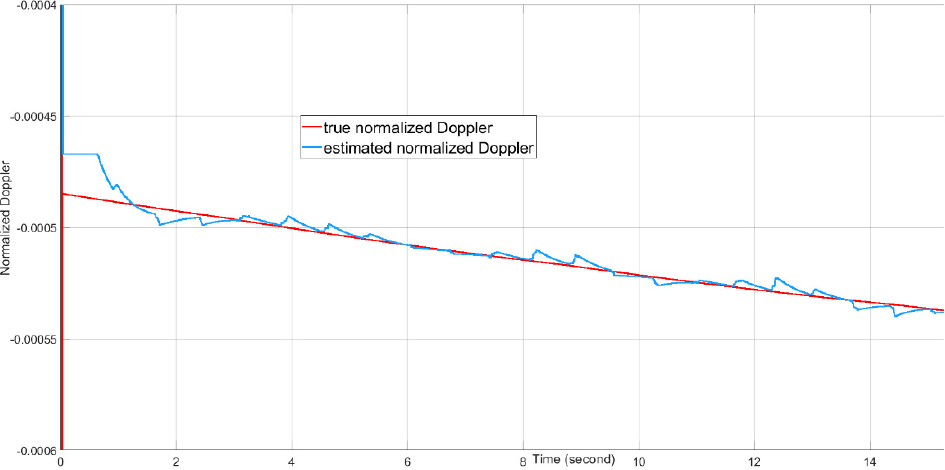
Figure 18. The normalized Doppler tracking performance over time. The estimation error ramps up from time to time. This is likely due to the interaction of the Doppler tracking loop and the monopulse angle tracking loop, as shown in Figure 5.